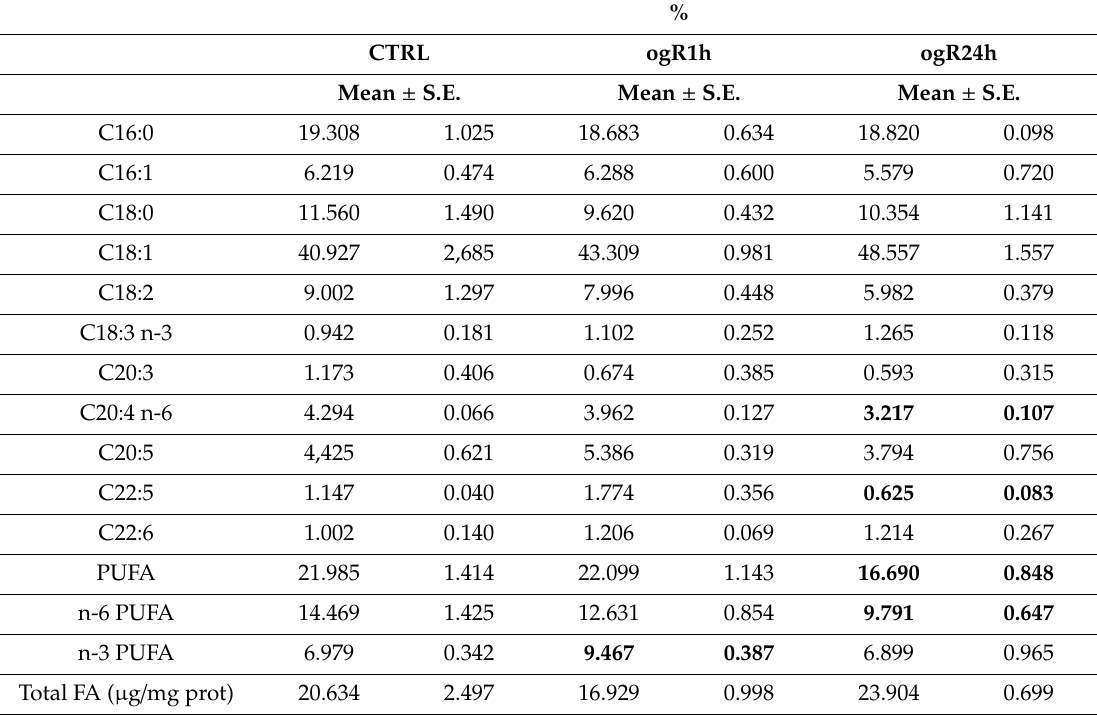
Table 1. FA composition of neutral lipids purified by High Performance Liquid Chromatography (HPLC) from RBE4 endothelial cells after OGD / ogR treatment for 1 and 24 h. % CTRL